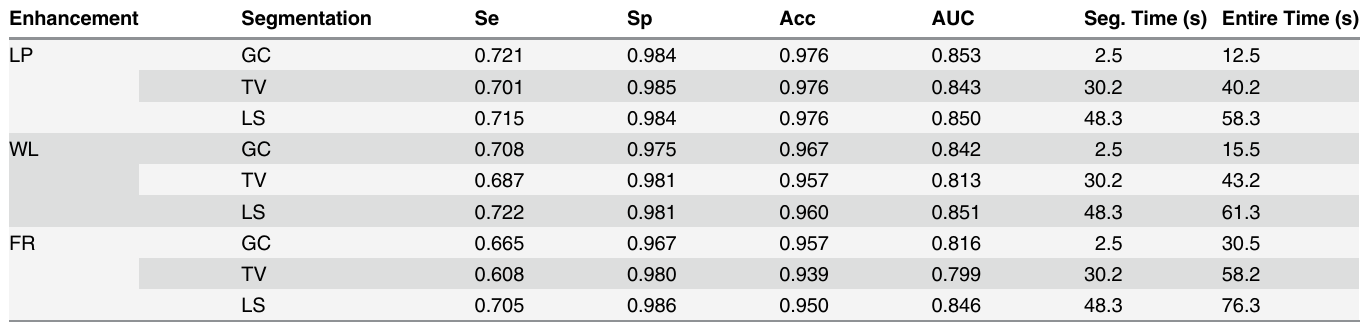
Table 5. Segmentation performance of different possible combinations of three enhancement methods (LP, WL, FR) and three segmentation meth- ods (GC, TV, LS) on the VAMPIRE dataset. LP, WL and FR denote local phase, wavelet and Frangi ’ s eigenvalue based enhancement filters respectively. GC, TV and LS denote graph cut, total variation and level set based segmentation methods respectively. Se : sensitivity; Sp : specificity; Acc : accuracy; AUC : area under the curve. Enhancement